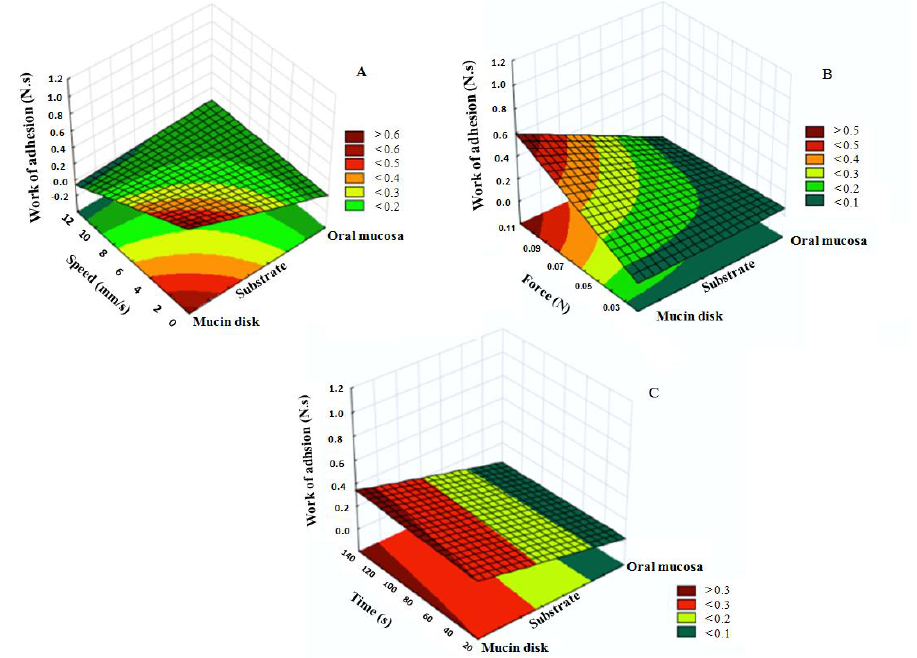
Figure 4. Response surface graphs of the work adhesion (W adh ) using mucin disk or oral mucosa influenced by some factors: ( A ) speed of probe ascent (mm/s); ( B ) applied force (N); ( C ) analysis time (s).